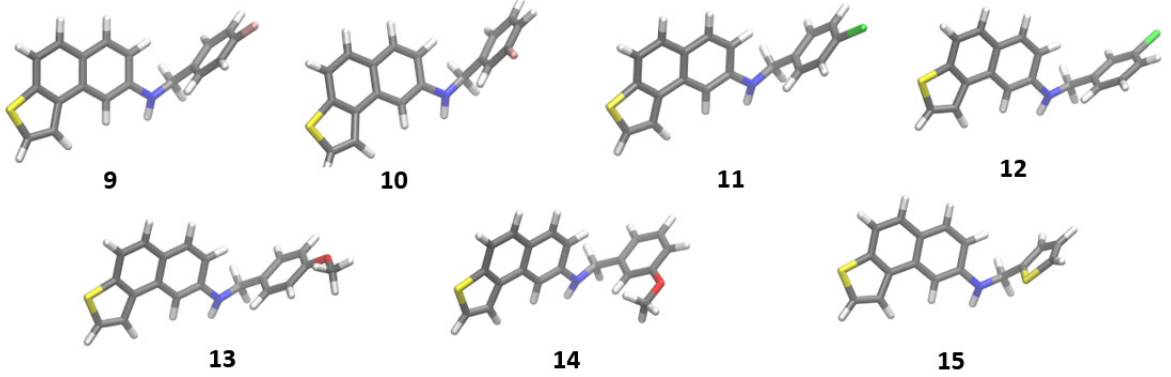
Figure 10. The most stable conformers of trans -isomers of naphtho-thiophene benzylamines 9 – 15 , optimized at the M06-2X/6-31g(d) level of theory.